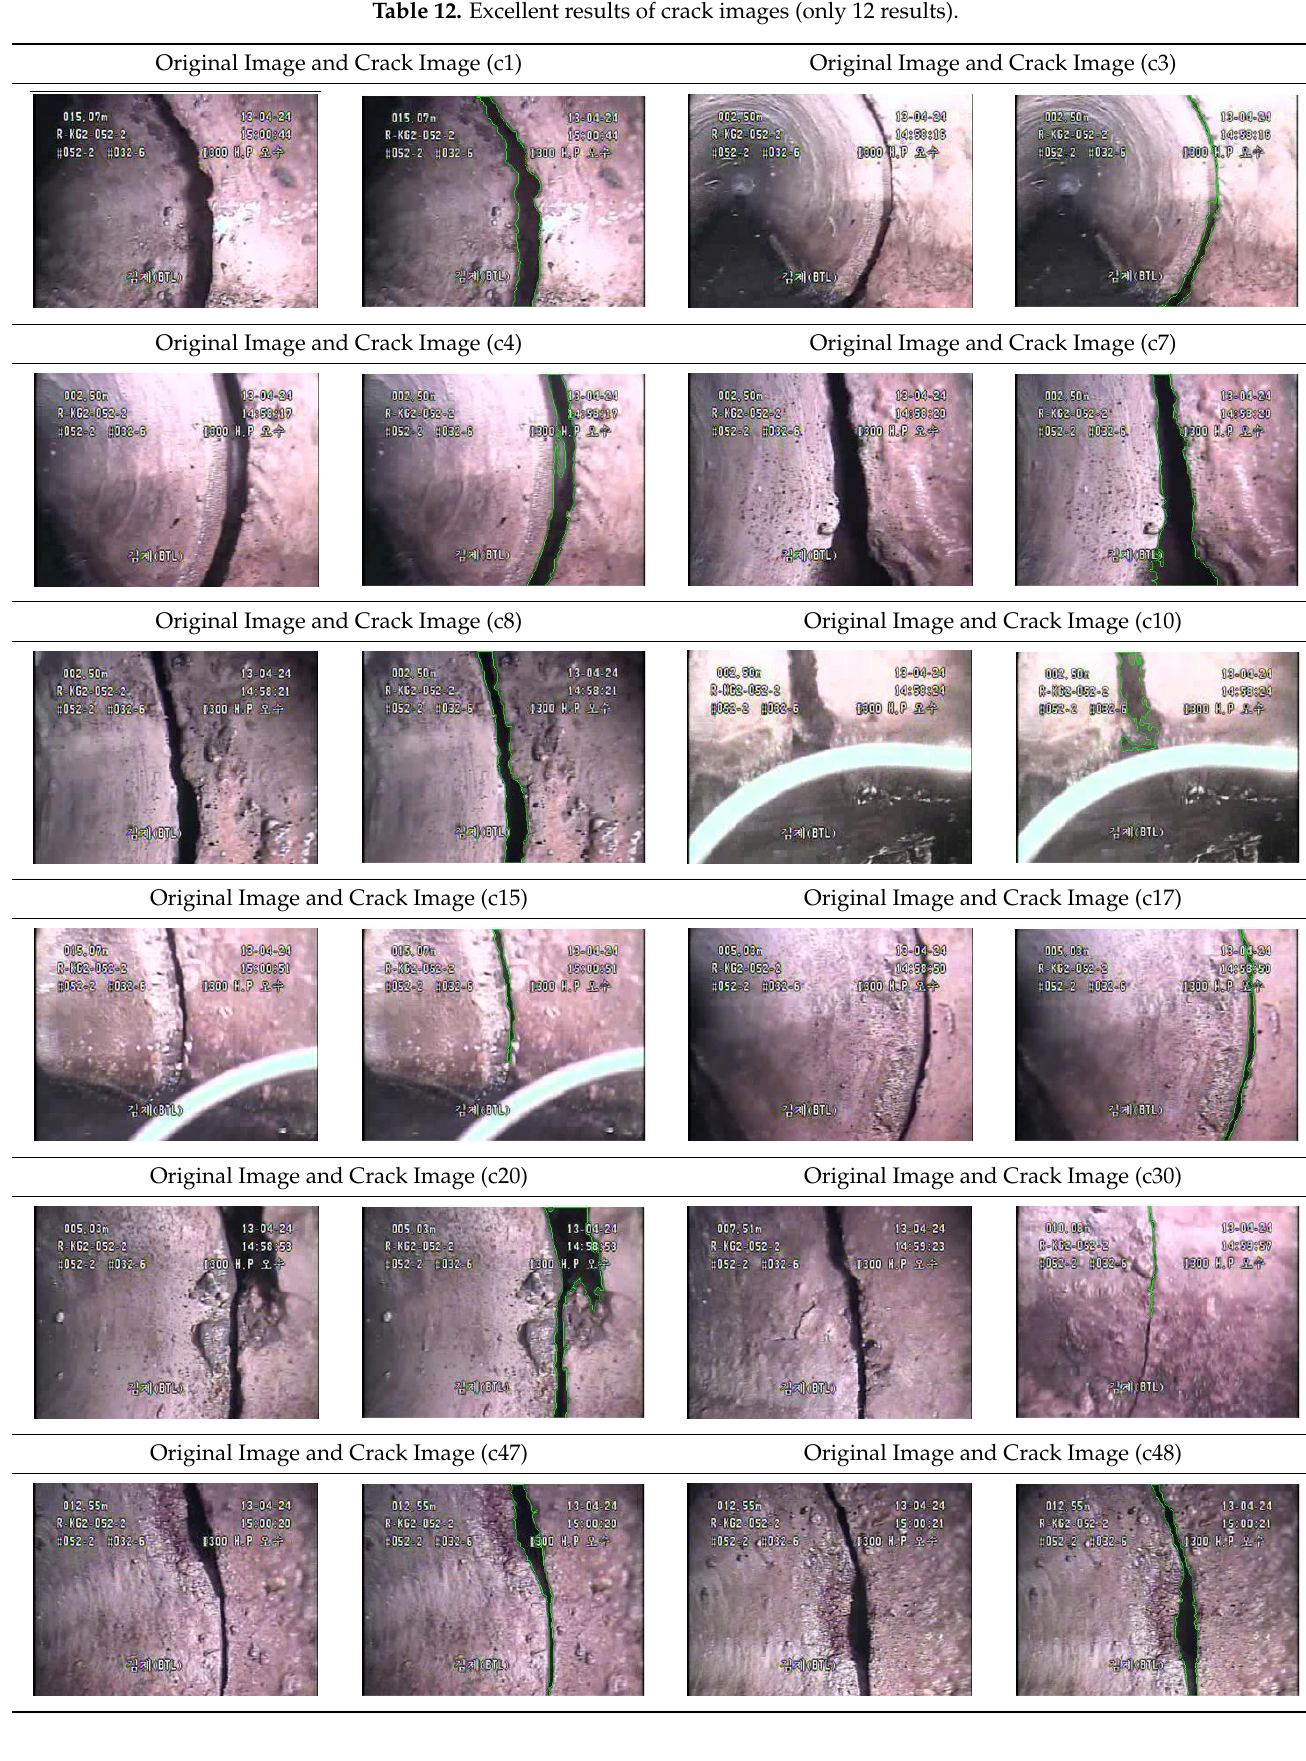
Table 13. Good results of crack images (all results).